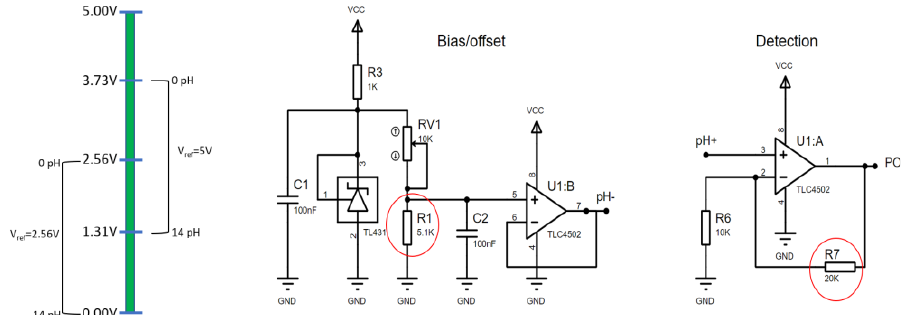
Figure 8. The signal conditioning stage can be improved by optimizing the usable detection range of the ADC. We propose to modify the feedback resistor and the (fixed) voltage divider network resistor to improve the performance by a two-fold factor: from 48 to 98% usable detection range.